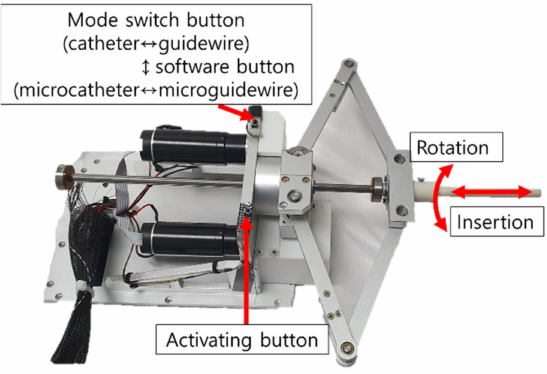
Figure 3. Motions and buttons of the ergonomically designed 2 DOFs master